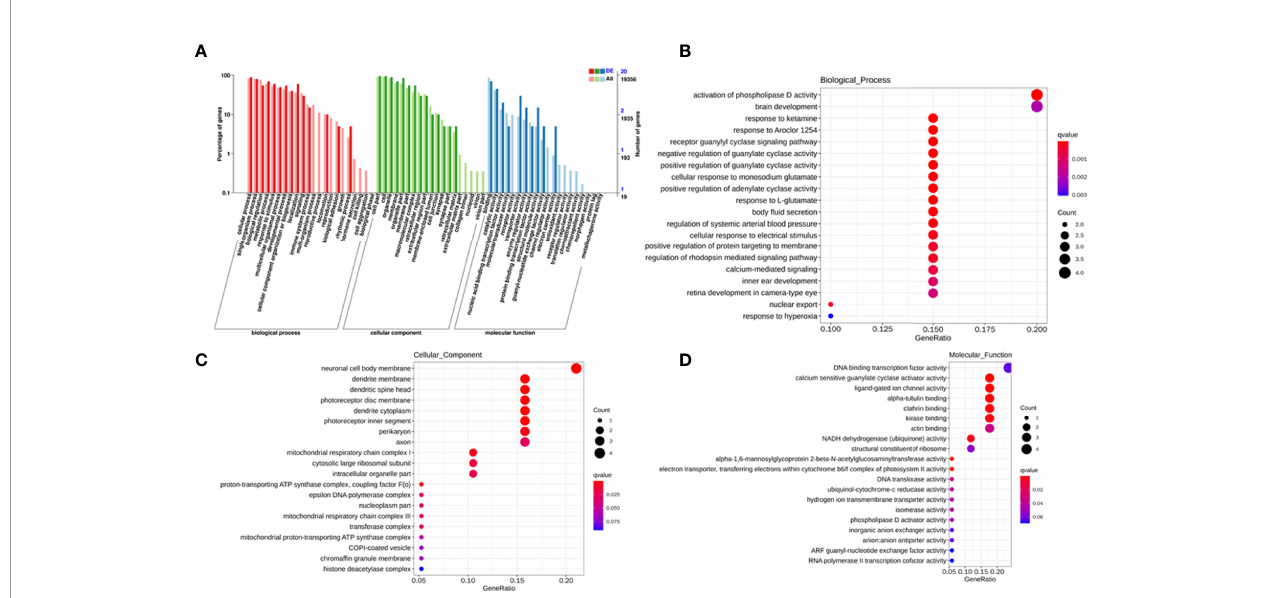
FIGURE 4 | GO terms of cis-acting genes of differentially expressed exosomal lncRNAs. GO categories of differentially expressed lncRNAs (A) . Top 20 signi fi cant enriched biological processes (B) , cellular components (C) , and molecular functions (D) of differentially expressed